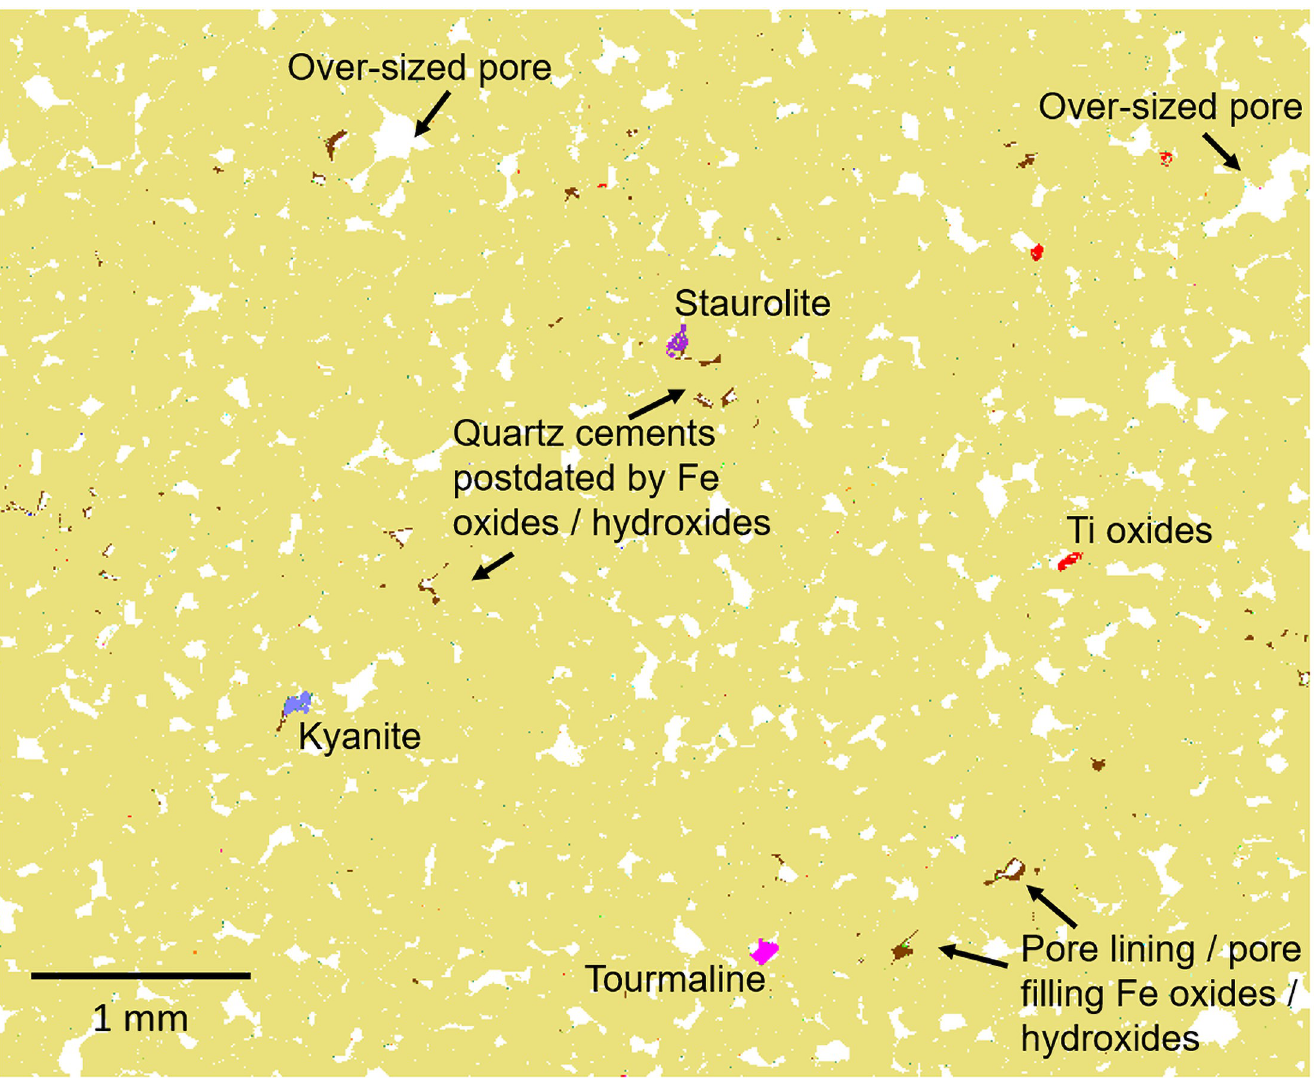
Fig 12. Automated SEM-EDS (QEMSCAN) mineralogical map (for area of thin-section SH2B from the Phillips’ Core detailed in Fig 11) highlighting textural features.